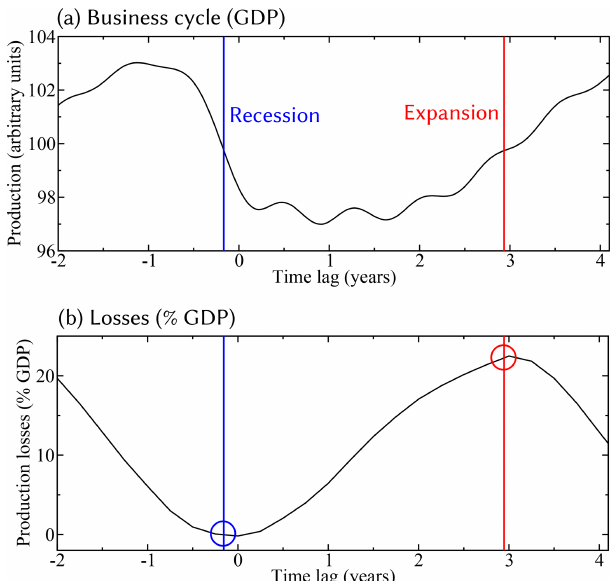
Figure 7. Vulnerability paradox – the effect of a single natural dis- aster on an endogenous business cycle (EnBC). (a) The business cycle in terms of annual production, as a function of time, starting at the cycle minimum (time lag = 0). (b) Total production losses due to a disaster that instantaneously destroys 3% of gross domes- tic product (GDP), shown as a function of the cycle phase in which the disaster occurs; the phase is measured as a time lag with respect to cycle minimum. A disaster occurring near the cycle’s minimum (blue vertical line in both panels) causes a limited indirect produc- tion loss (blue circle), while a disaster occurring during the expan- sion (red vertical line in both panels) leads to a much larger loss (red circle). Figure courtesy of Andreas